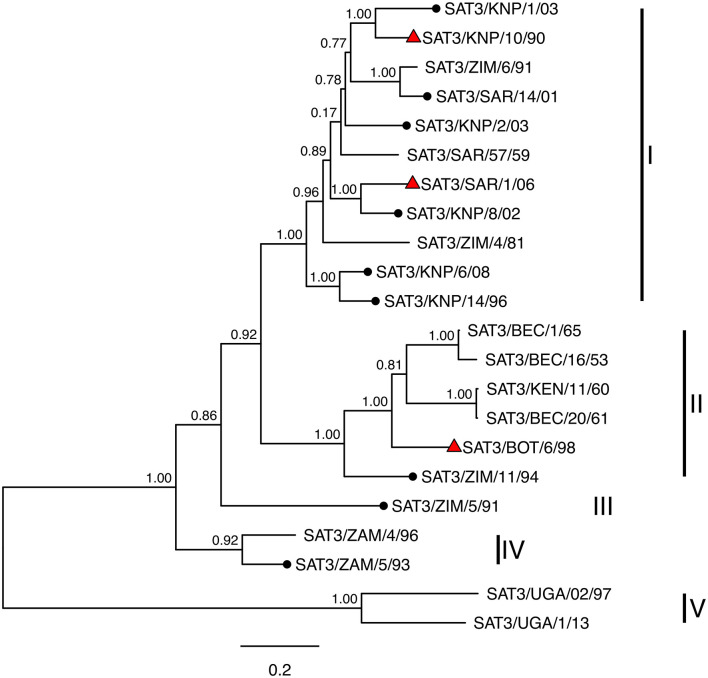
Maximum likelihood phylogenetic tree constructed from aligned capsid (P1) nucleotide sequences, with mid-point root. Clades of the phylogeny corresponding to topotypes are labeled. Viruses tested as antigen in virus neutralization (VN) assays are marked with black circles and reference viruses also used to generate antiserum for VN assays are marked with red triangles. Internal nodes are labeled with bootstrap values and branch lengths indicate the estimated number of nucleotide substitutions per site.